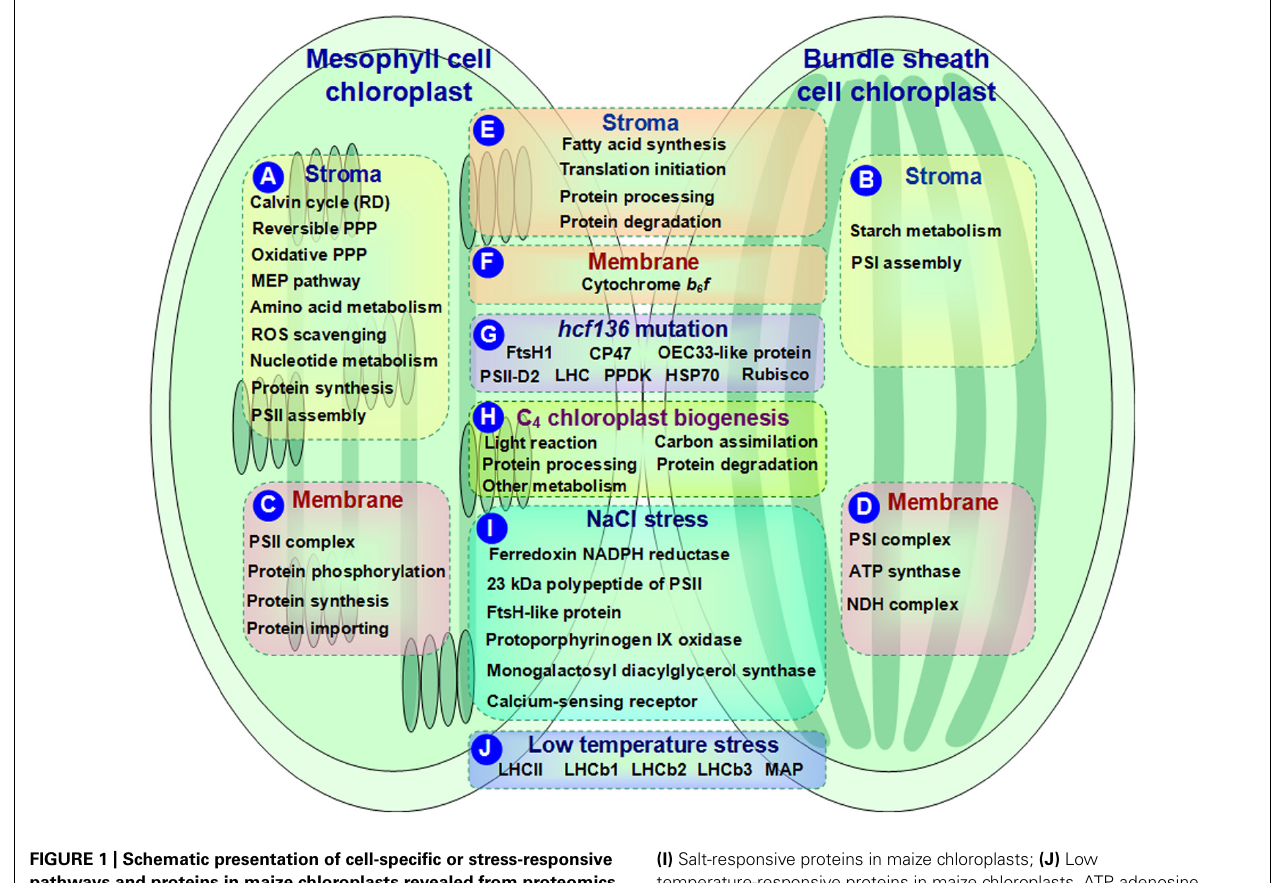
FIGURE 1 | Schematic presentation of cell-specific or stress-responsive pathways and proteins in maize chloroplasts revealed from proteomics studies. (A,B) Preferential metabolic pathways in the stroma of M and BS, respectively; (C,D) Preferential metabolic pathways and protein complexes in the chloroplast membrane of M and BS, respectively; (E,F) Metabolic pathways and protein complexes equally distributed in the chloroplast stroma/membrane of M and BS; (G) Differentially expressed proteins in chloroplasts of maize hcf136 mutant in comparison to wild-type; (H) Dynamics of metabolic pathways during maize chloroplast biogenesis;